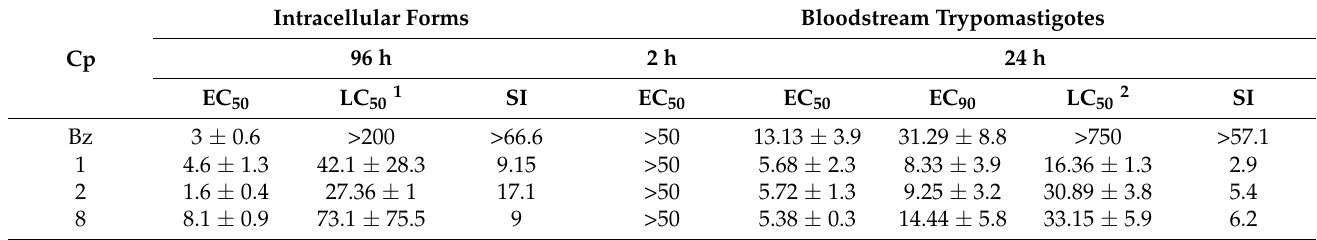
Table 4. Activity of the purified substances against intracellular and bloodstream forms of T. cruzi (EC 50 µ M) mammalian